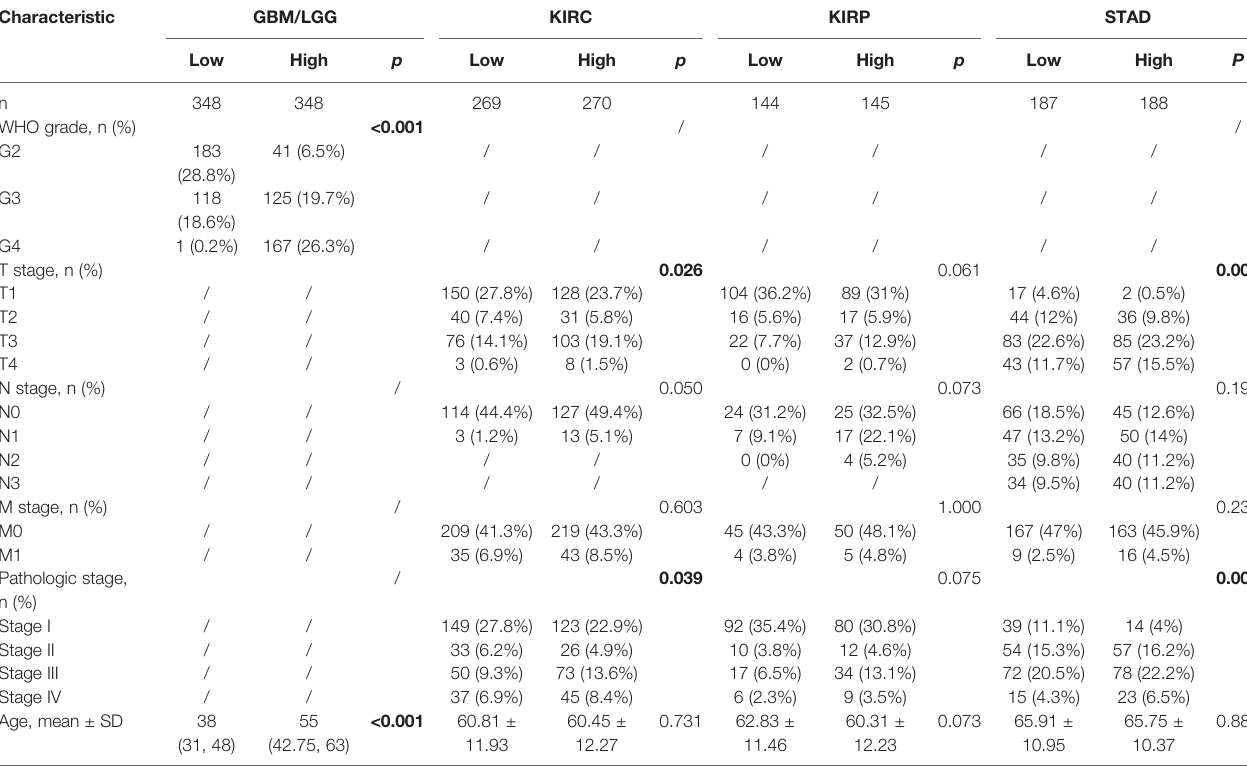
The meaning of the bold values was regarded as statistically signi fi